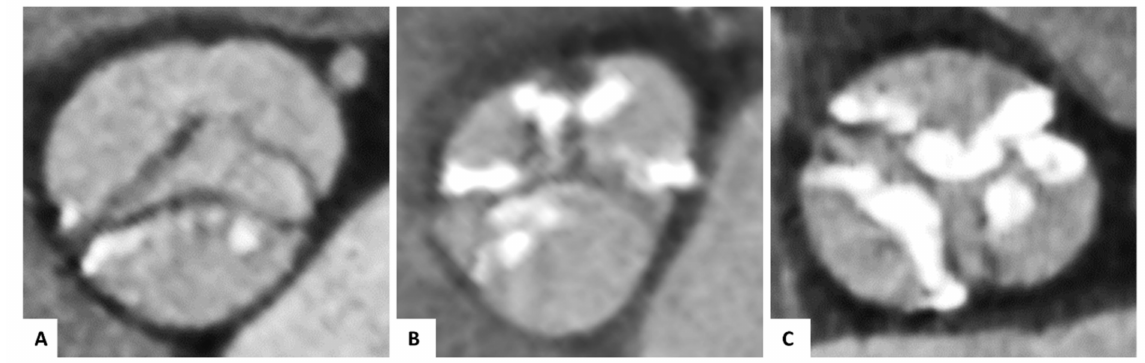
Figure 3. Semiquantitative calcification assessment of the device-landing zone. Pre-TAVI contrast-enhanced CTA of congenital and functional bicuspid aortic valves for visual calcification assessment with examples for mild ( A ), moderate ( B ), or severe ( C ) calcification of the cusps